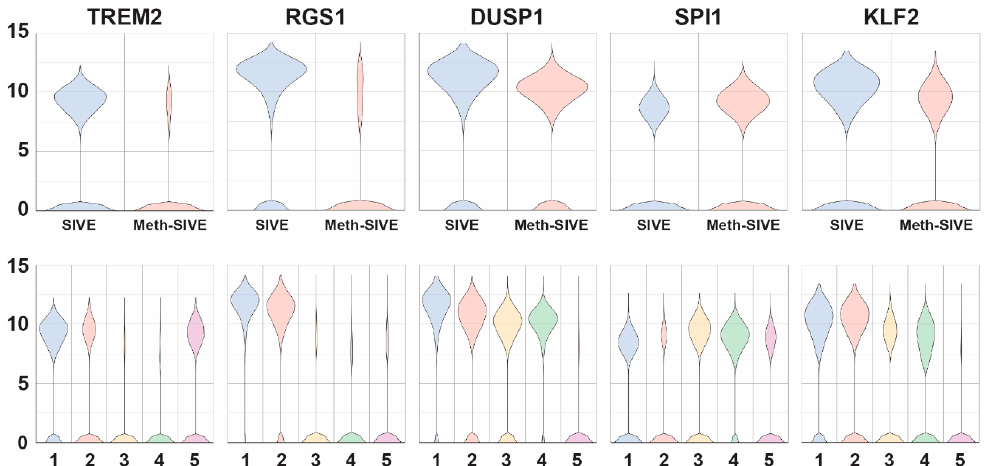
Figure 7. Violin plots showing the relative expression of regulatory genes in the two different conditions (upper) and the five different clusters (lower). The genes shown are bolded in the text.